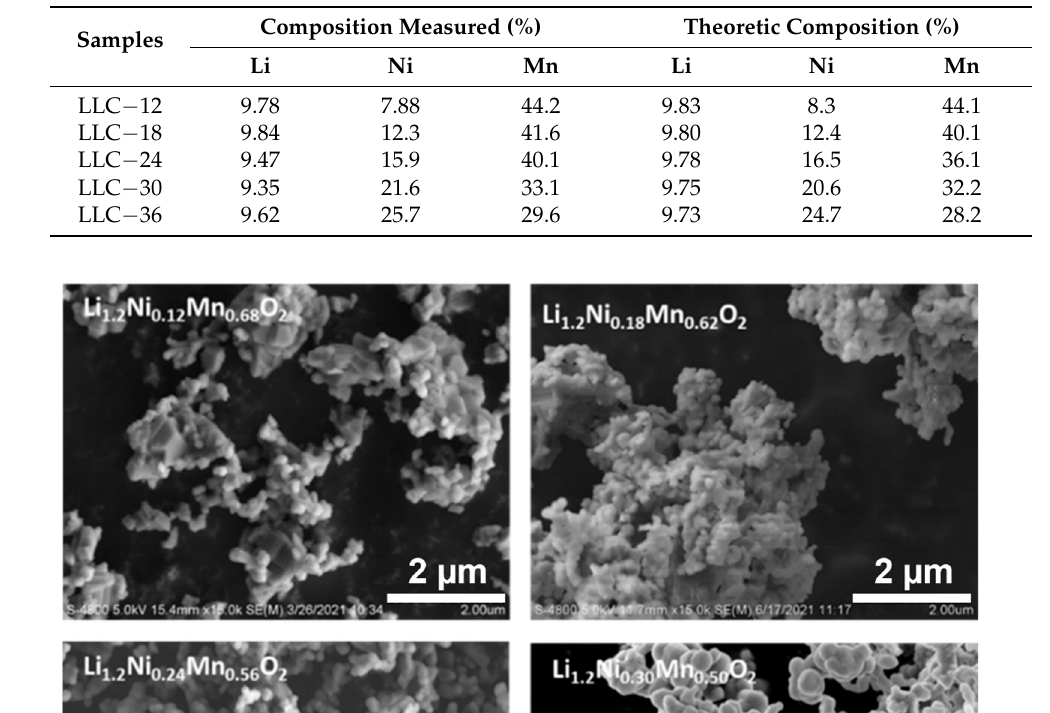
Table 2. Composition of Li, Ni and Mn for the as-prepared samples.